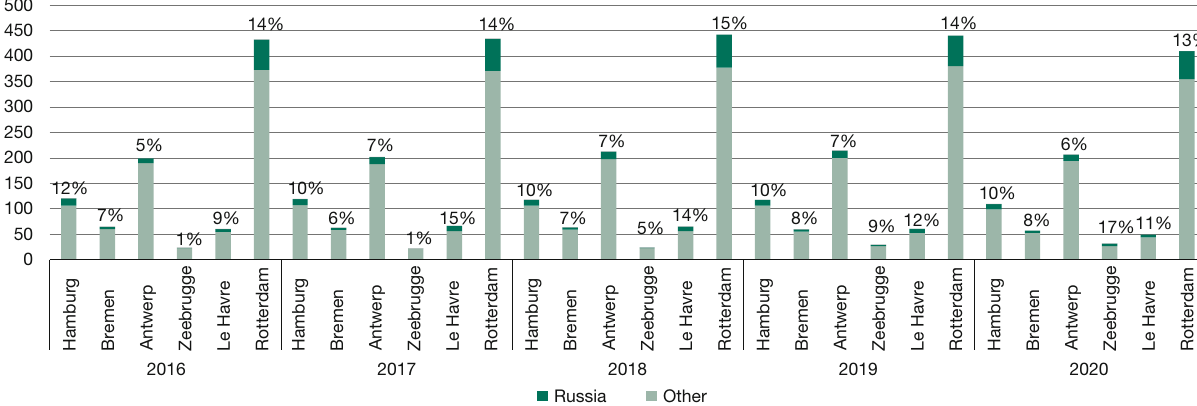
recovery process hoped for in 2022 was interrupted by Russia’s war in Ukraine. Not only were the supply chains running through Ukraine aff ected here, but the West’s strict sanction policy against Russia is disrupting inter- national trade (Berlemann et al., 2022). Currently, there is no end in sight, which implies a potential disruption to trade through the North Range ports. Figure 4 Share of Russian good throughput in the North Range ports, 2016-2020 Total volume in million tonnes